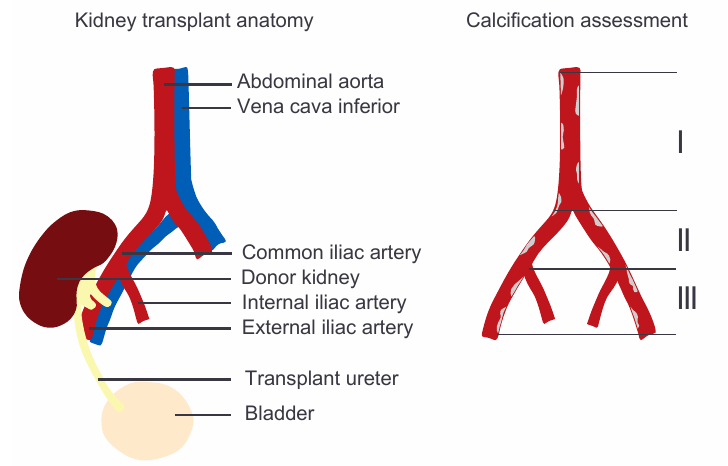
Figure 1. Graphical image of the kidney transplant anatomy and the aorto-iliac calcium score (CaScore) assessment performed in three vascular segments, being (I) the abdominal aorta inferior of the renal arteries, (II) the common iliac artery, and (III) the external iliac artery on the side of the subsequent transplant.